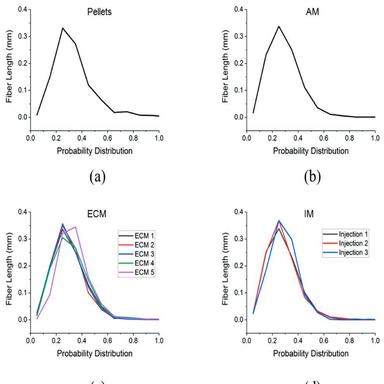
Probability distribution of CF length (a) Pellets (b) AM (c) ECM (d) IM.